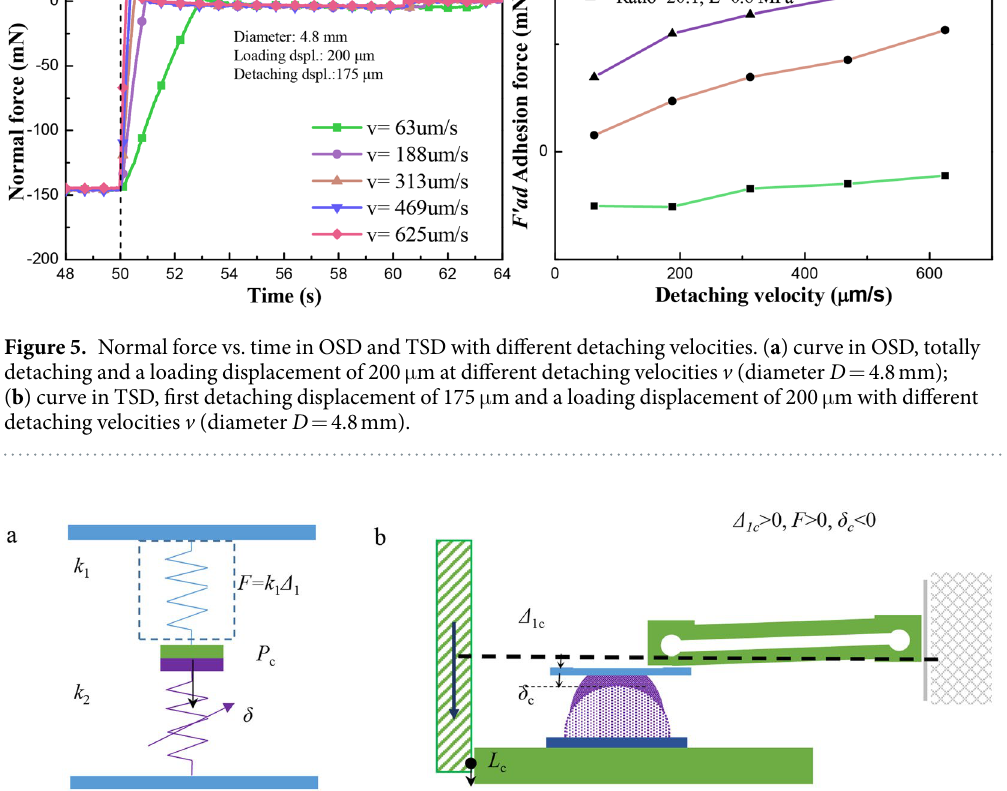
Figure 6. The spring model of the adhesion measuring